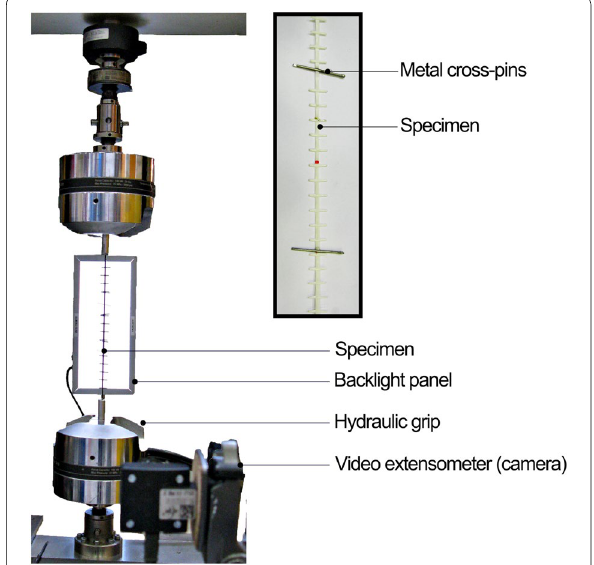
Fig. 2 Overview of the tensile test setup. Reproduced with permission from (Williams Portal et al.